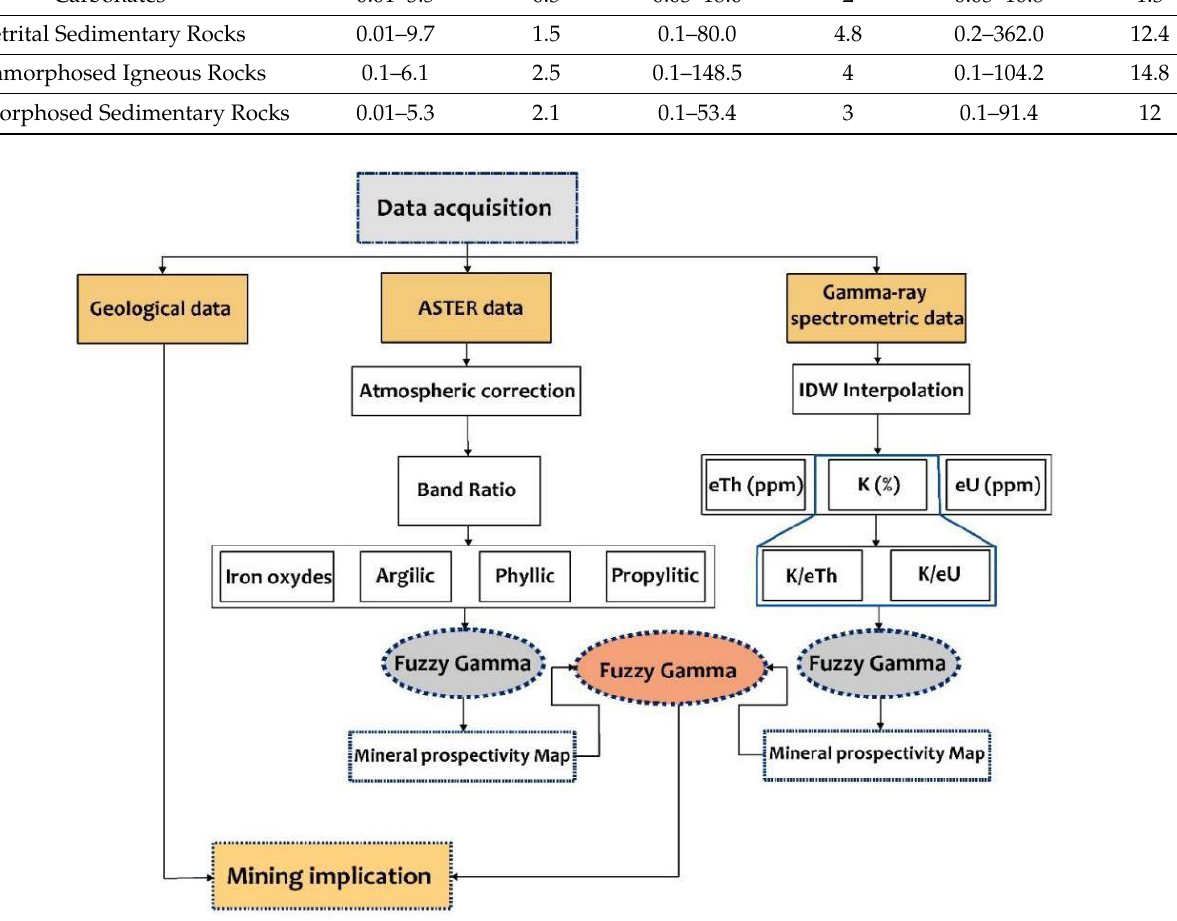
Figure 3. The methodological flowchart used in this study.